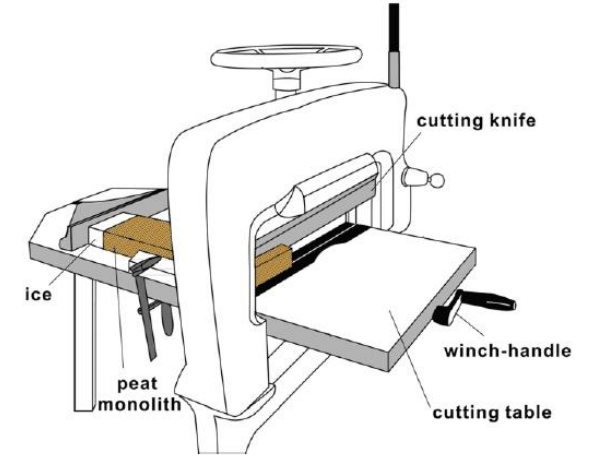
Figure 2. Cutting with DAMOCLES [17] (p. 77, modified).